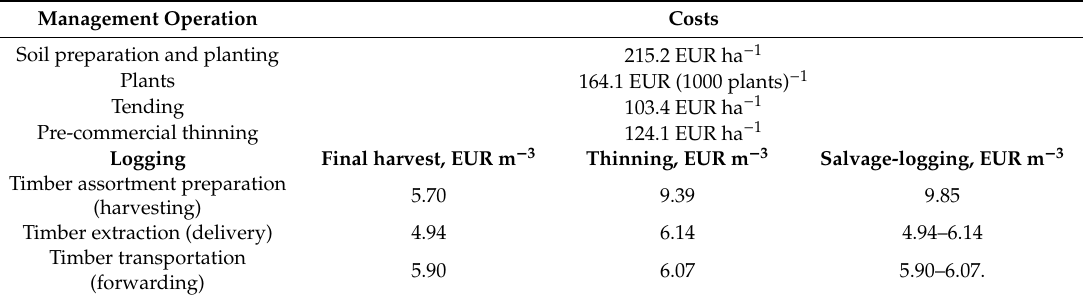
Table 2. Forest management operations and their